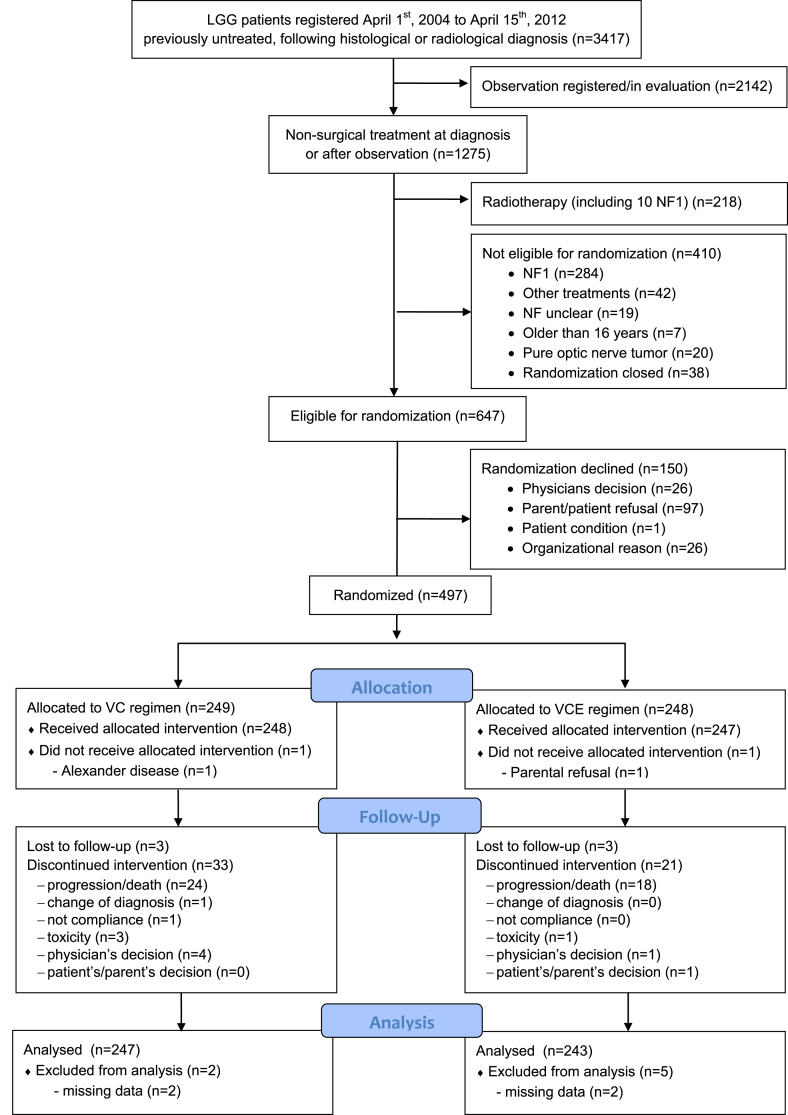
CONSORT diagram.